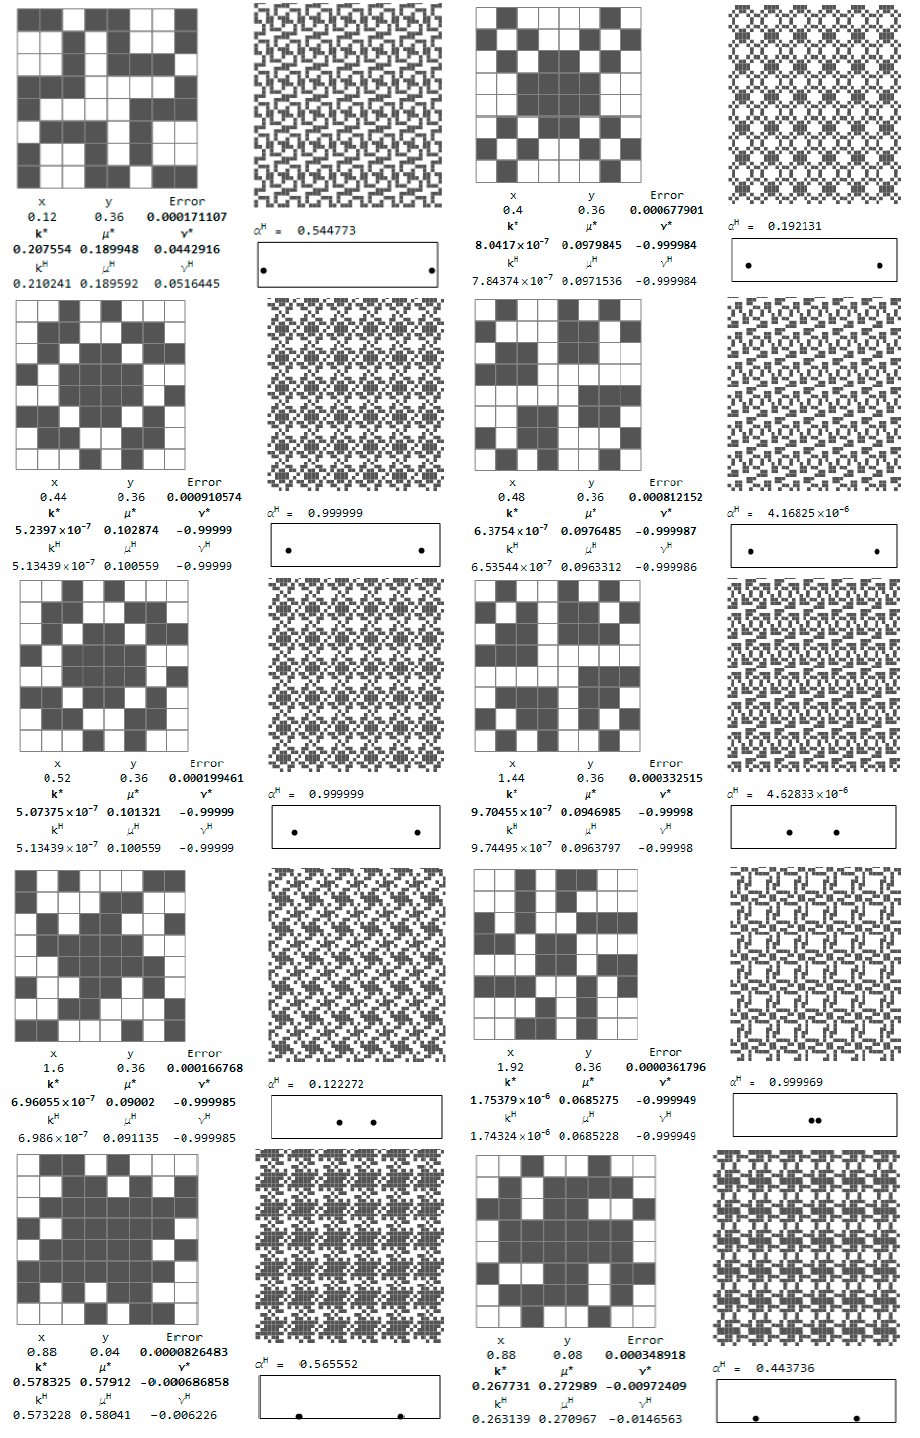
Figure 17. Optimal isotropic microstructures approximating the IMD results with the error (Equation (28)) less than 0.001.